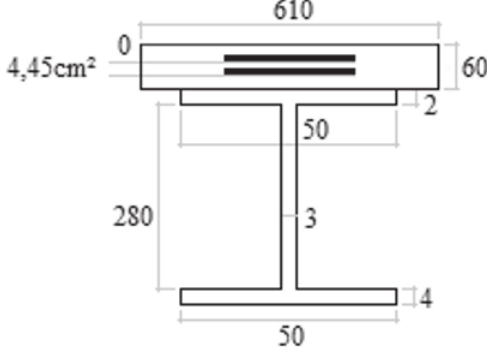
Optimized non-symmetric section obtained by the algorithm (dimensions in mm)